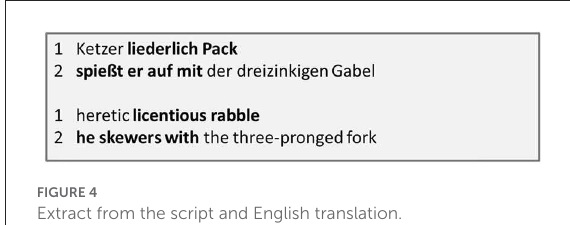
FIGURE4 Extract from the script and English